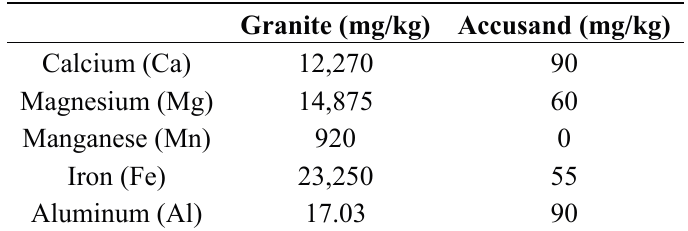
Table 4. Elemental analysis of the two media used in filter